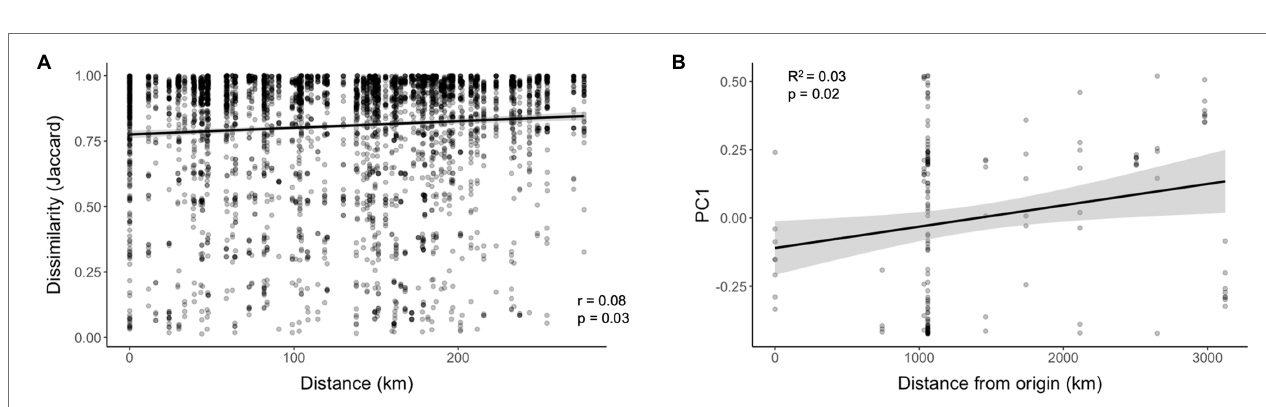
FIGURE 5 | Correlations at various spatial scales between (A) Haversine distance and microbiome community dissimilarity (Jaccard) and (B) Haversine distance from ancestral population (Arizona) of Diabrotica virgifera virgifera (WCR) and values from axis 1 of PCoA of microbiome community similarity based on Jaccard distance.